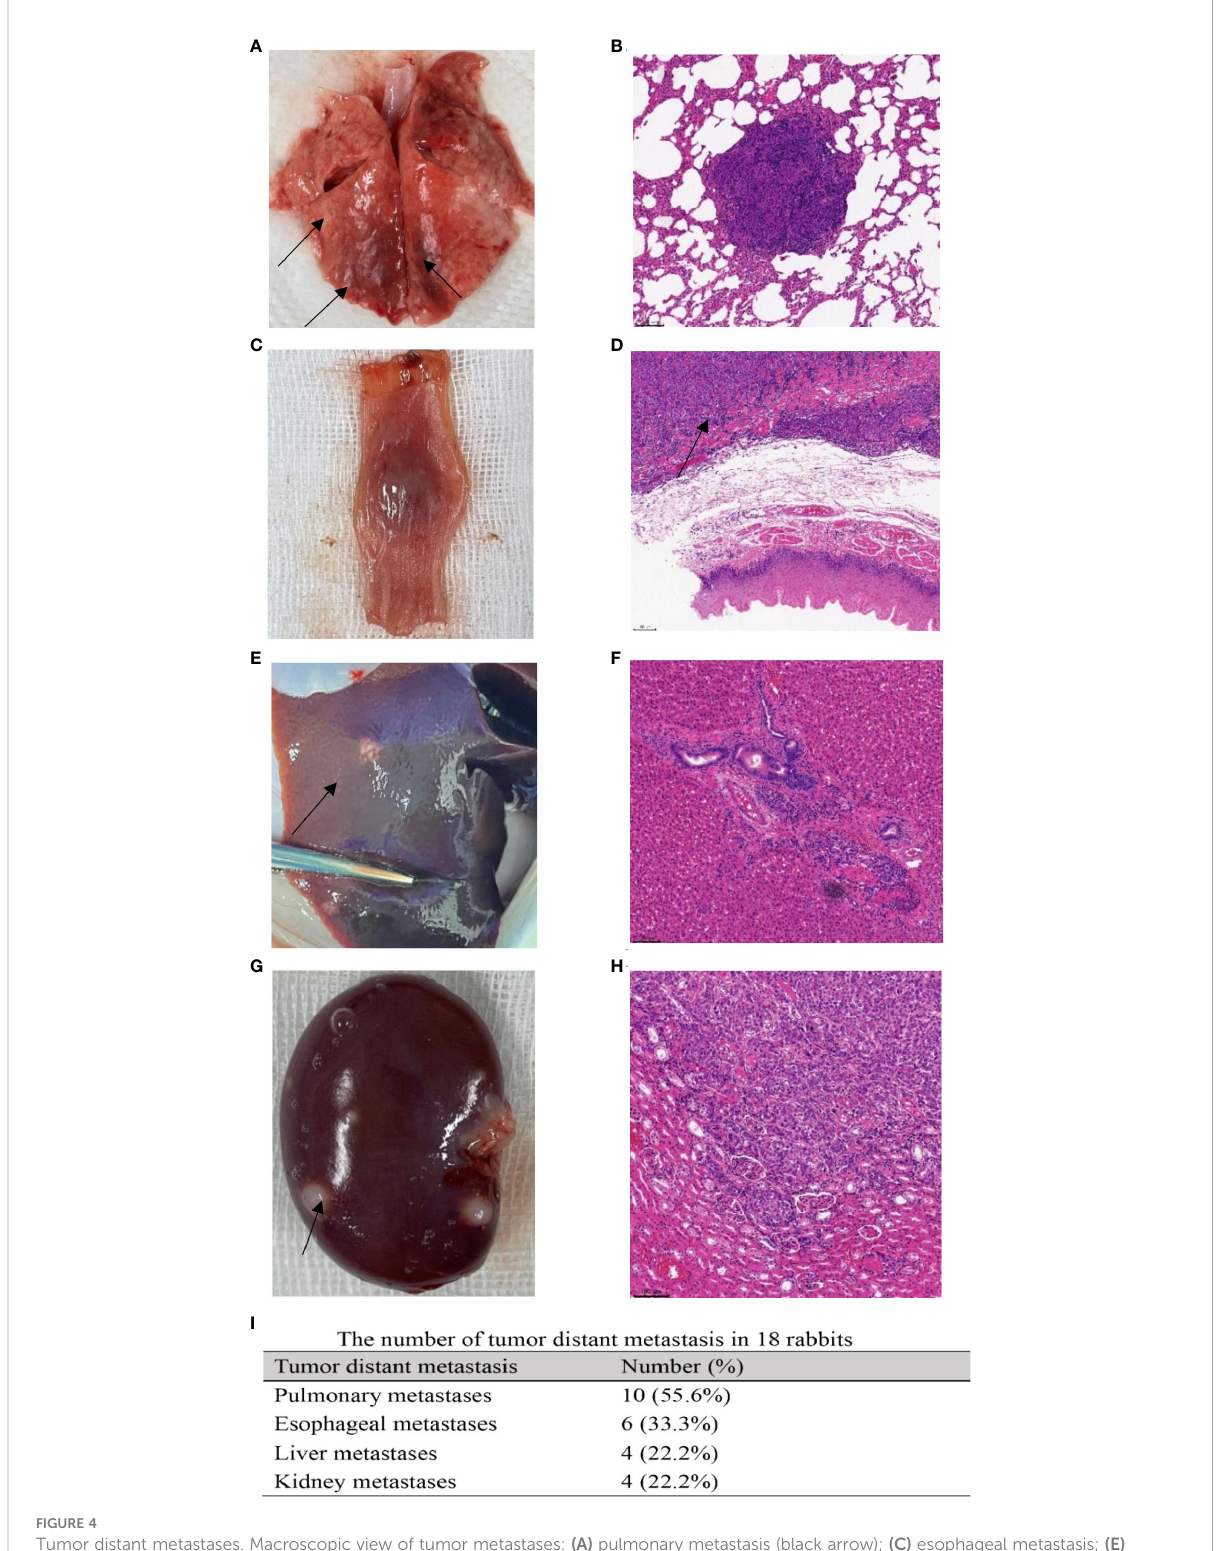
FIGURE 4 Tumor distant metastases. Macroscopic view of tumor metastases: (A) pulmonary metastasis (black arrow); (C) esophageal metastasis; (E) hepatic metastasis (black arrow); (G) renal metastasis (black arrow). Microscopic observation of tumor metastases: (B) pulmonary metastasis; (D) esophageal metastasis. The black arrow points to cancer cells in fi ltrating the esophageal muscular layer. (F) Hepatic metastasis. (H) Renal metastasis. (I) The number of tumor distant metastases in 18